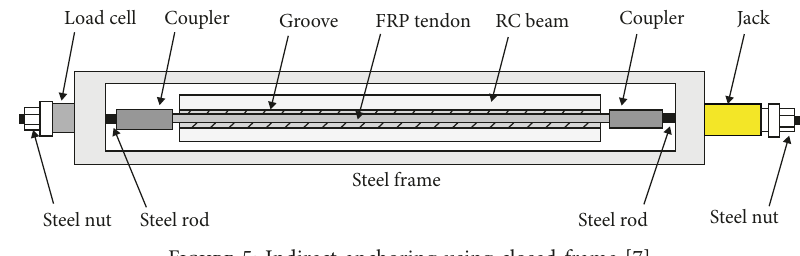
Figure 5: Indirect anchoring using closed-frame [7].